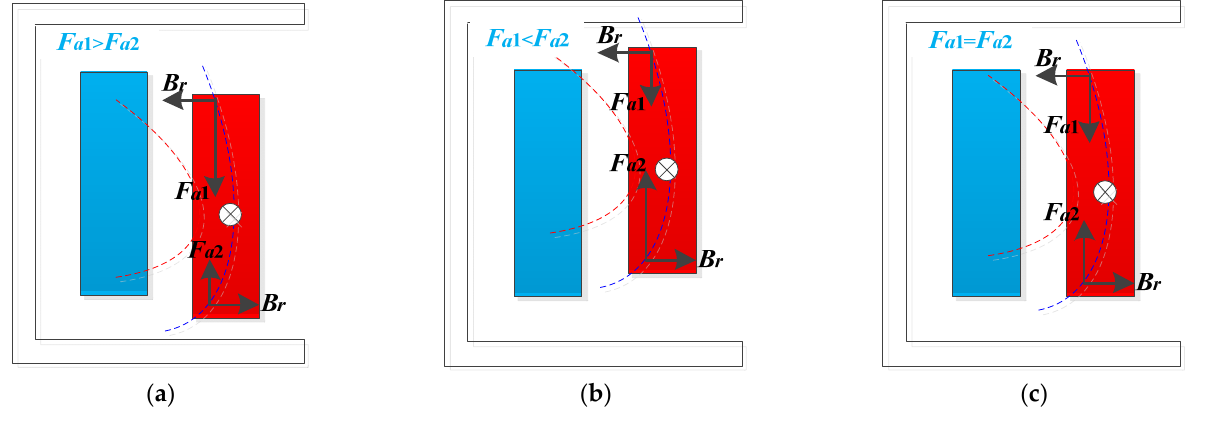
Figure 7. Deformation of the winding under axial force: ( a ) F a 1 > F a 2 ; ( b ) F a 1 < F a 2 ; ( c ) F a 1 = F a 2. The radial leakage generated at the end of the winding interacts with the inrush current to generate axial forces. The total axial force generated at the center of the winding can be found by Equation (15) [19–21].